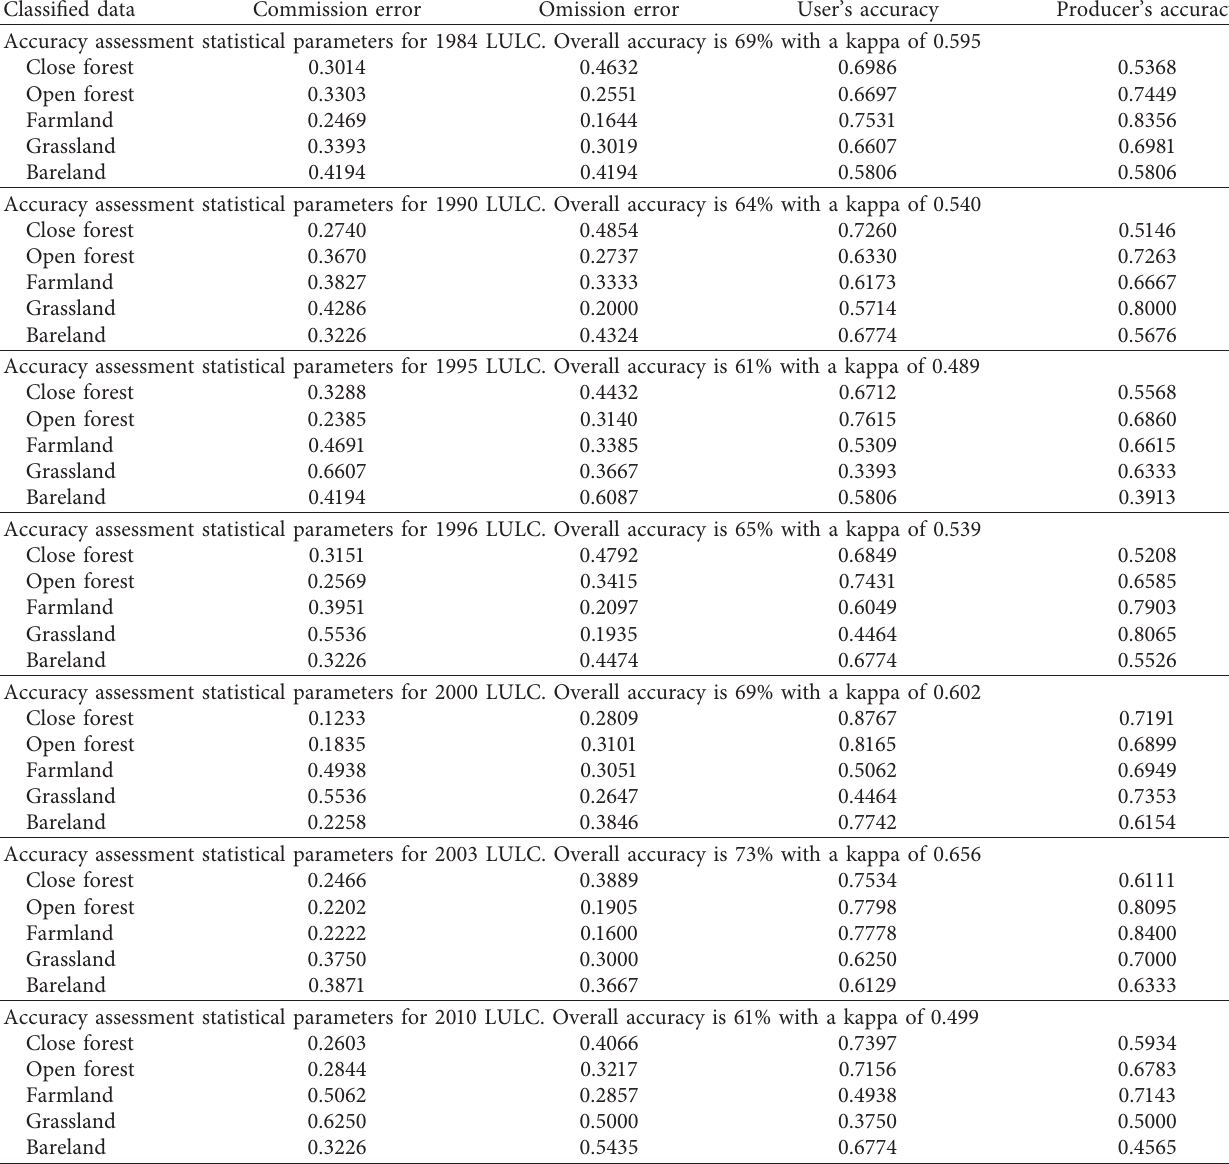
Table 7: Accuracy assessment statistical parameters for LULC classification.